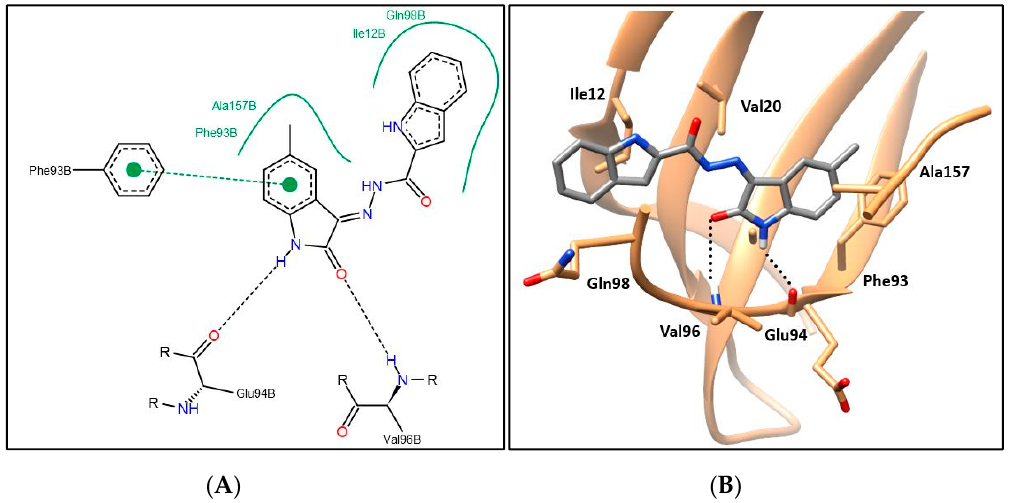
Figure 7. ( A ) The 2D diagram; ( B ) 3D representation for hybrid 6e displaying its interaction with the CDK4 binding site. Table 7. Docking energy scores (S) in kcal/mol for the conjugates 6a–i and the added oxindole ligand in the CDK4 binding site. Comp.